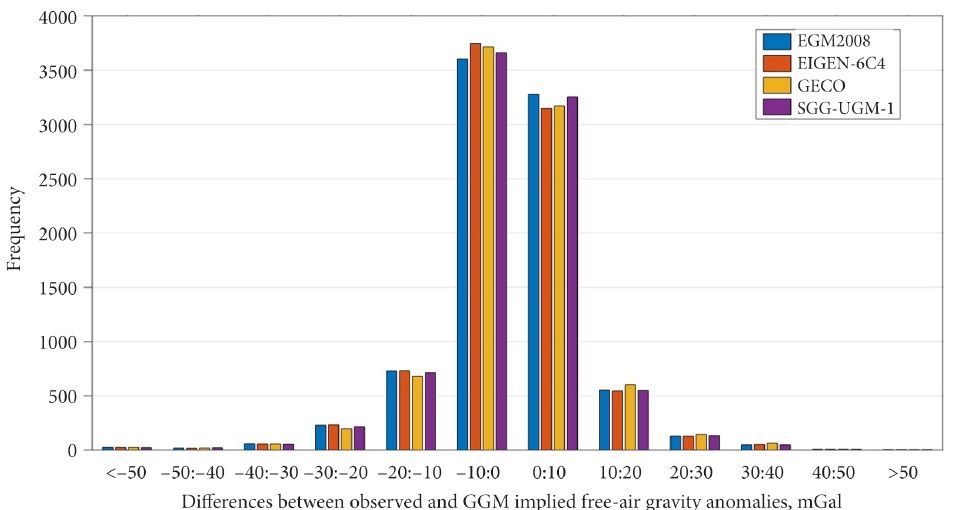
Figure 3. Differences between observed and GGMs implied gravity anomalies over Kenya at 8,690 gravity data points (units are in mGal)